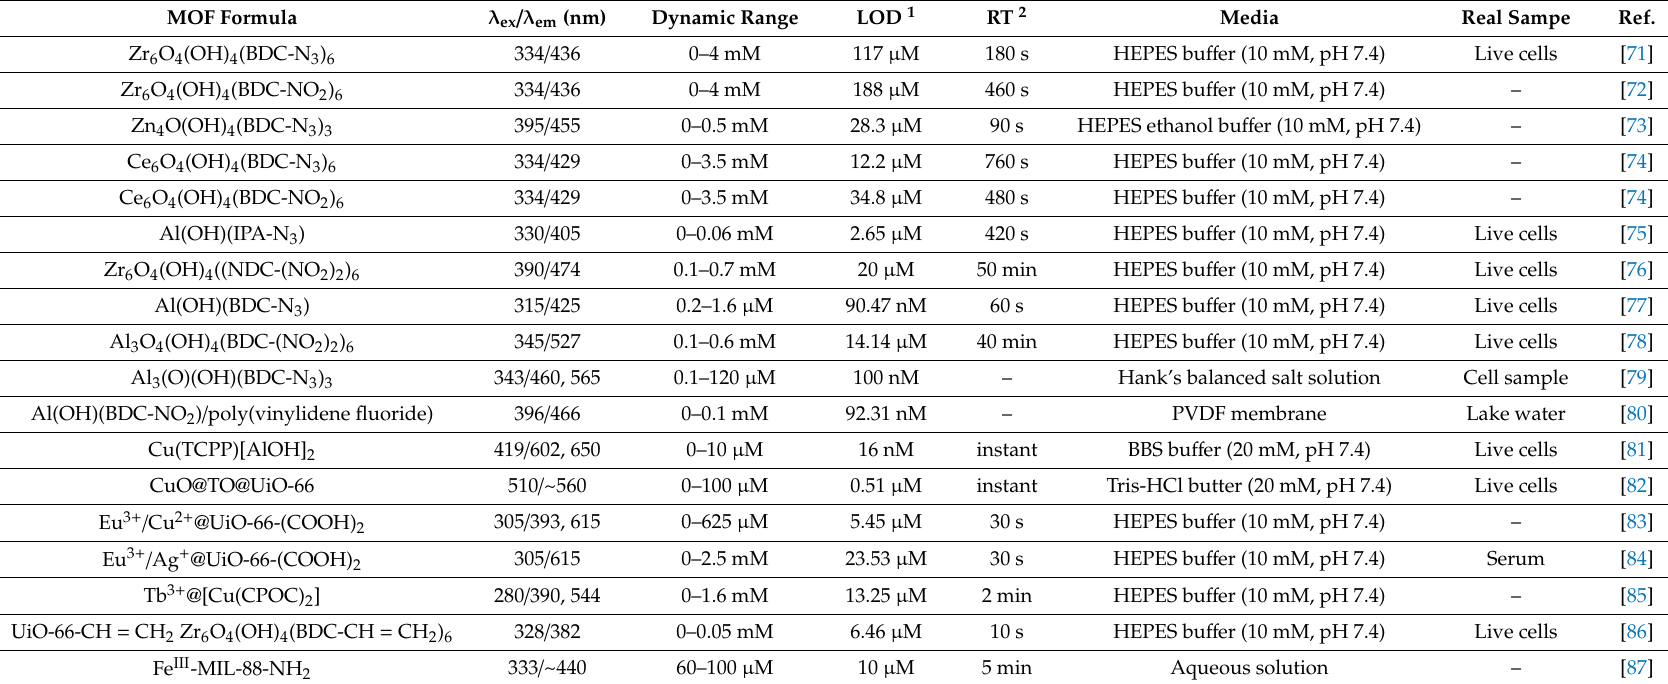
Table 1. List of MOF-based luminescent chemodosimeters for H 2